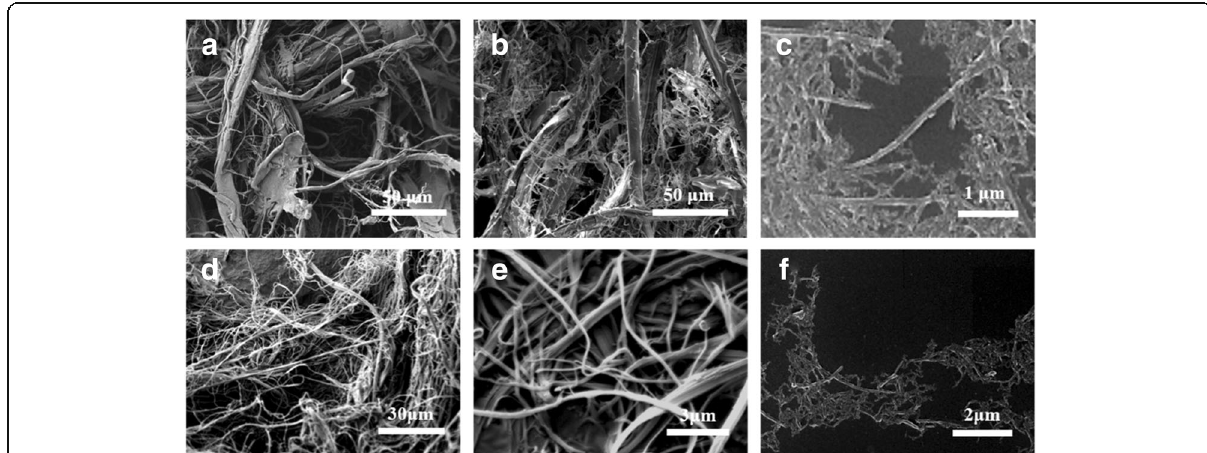
Fig. 2 Representative SEM observation of resultant silk fibers in each process. a Disassembled BS fibers after formic acid pretreatment, b oxidized BS fibers, and c the BS nanofibers with a diameter of 105 ± 27 nm. d Disassembled AS fibers after formic acid pretreatment, e oxidized AS fibers, and f the AS nanofibers with a diameter of 112 ± 33 nm. The contour length of BS and AS nanofibers is more than 1 μ